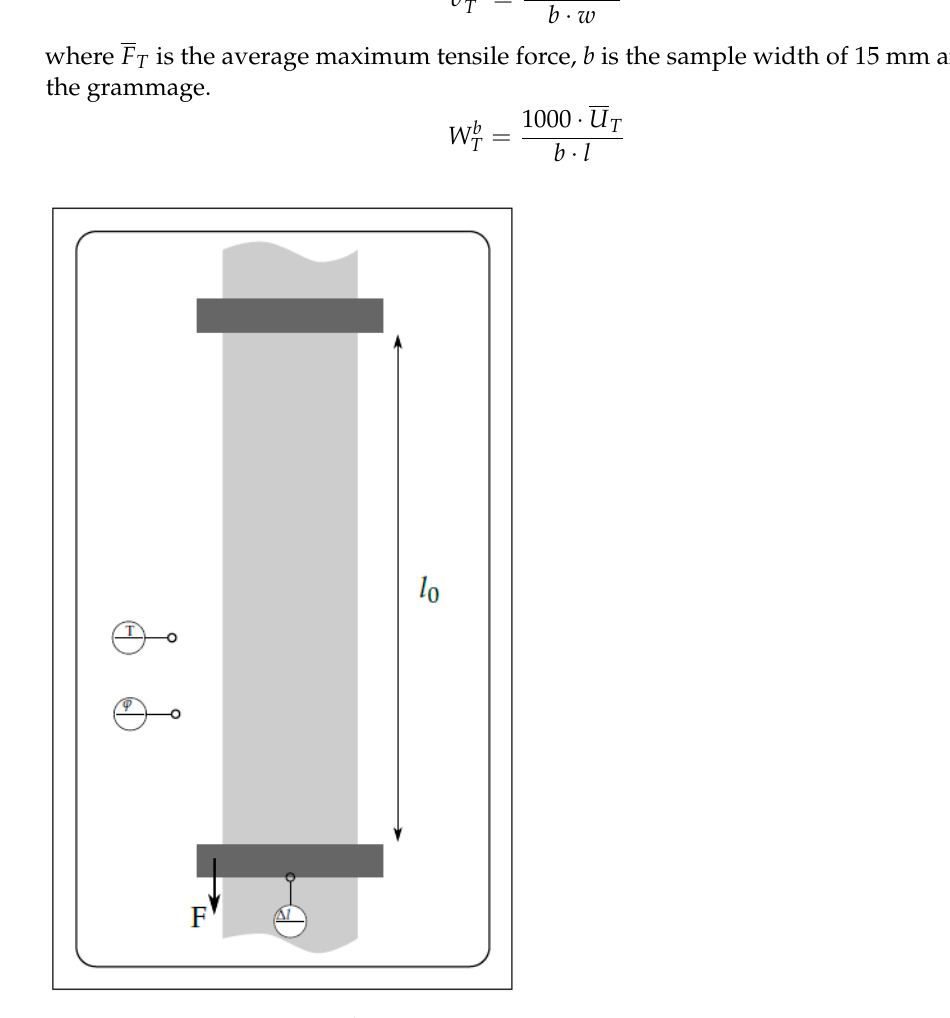
Figure 1. Measurement set-up hygroexpansion.